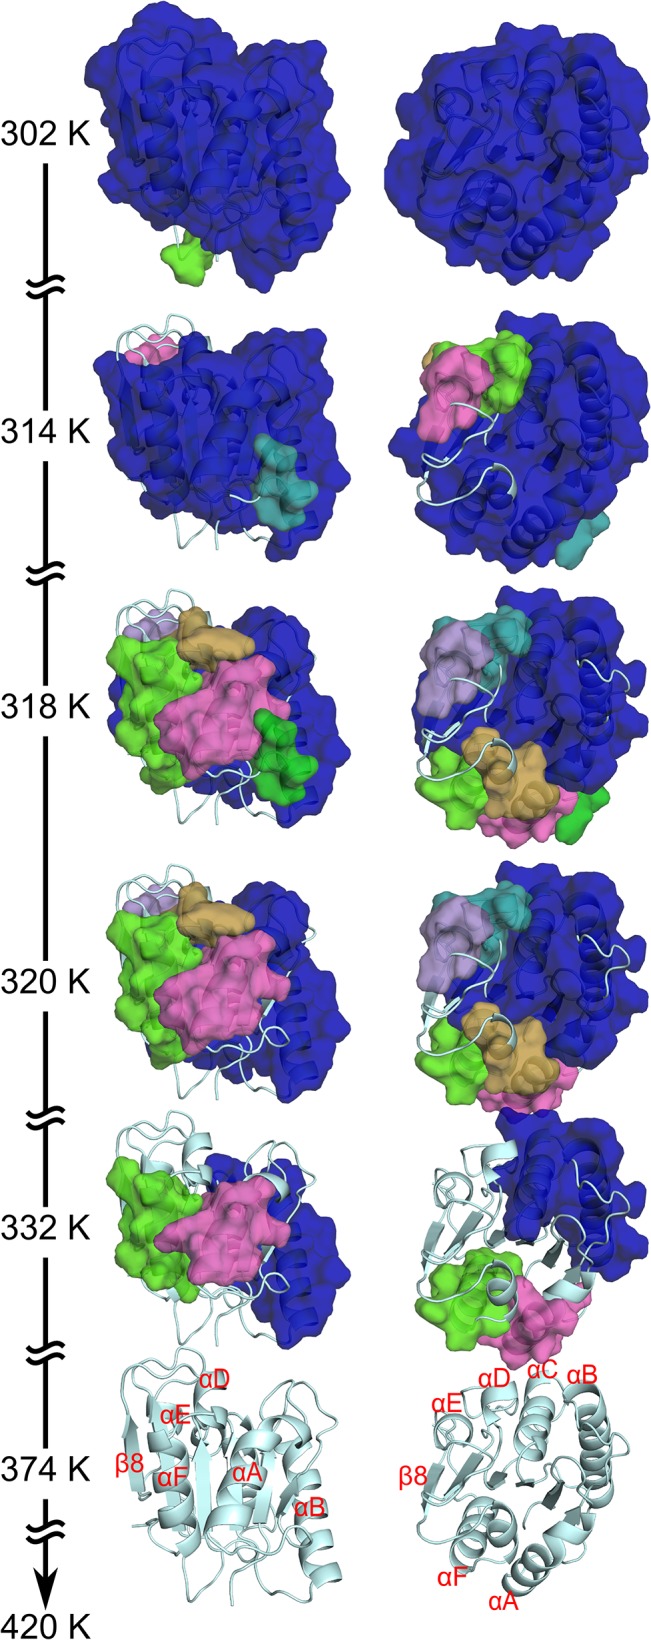
Average loss of structural rigidity of the wild type BsLipA during a thermal unfolding simulation.Rigid clusters are depicted as uniformly colored bodies, with the largest rigid cluster shown in blue and smaller rigid clusters in the order of the colors green, magenta, cyan, orange, and violet. Temperatures are indicated for each depiction of a rigid cluster decomposition. At the beginning of the thermal unfolding simulation (302 K), almost the complete structure is part of the giant rigid cluster; in contrast, the structure becomes completely flexible at temperatures ≥374 K. The right views differ from the left ones by an anti-clockwise rotation of ~90° about a horizontal axis. Important secondary structure elements are labeled. Note that the unfolding pathway shown here represents an average loss of rigidity percolation calculated from a stability map (see section “Local and global rigidity indices” in S1 File) averaged over all unfolding trajectories obtained for the ensemble of 2000 network topologies. Hence, the temperature at the phase transition point identified that way (Figure B in S1 File) cannot be compared to the average phase transition temperature, which is obtained from 2000 individual T
p values and used for predicting the thermodynamic thermostability of BsLipA variants (see section “Prediction of thermodynamic thermostability of BsLipA variants”)